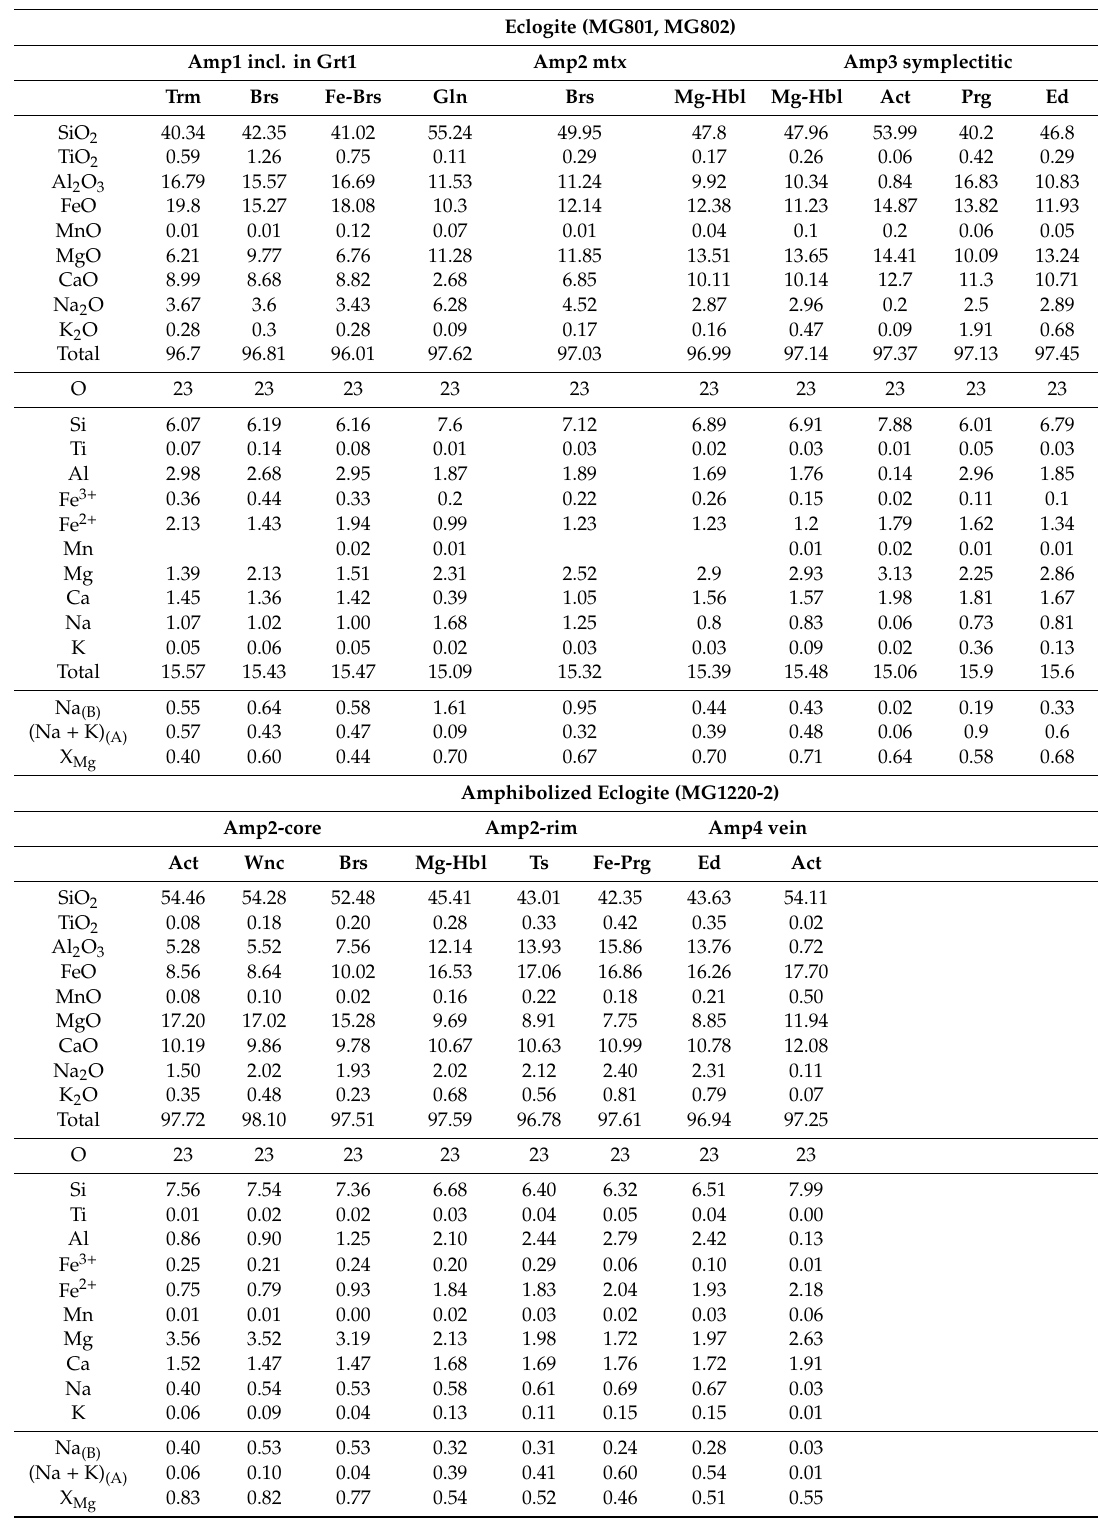
Table 3. chemical compositions of amphiboles from the eclogites and amphibolitized